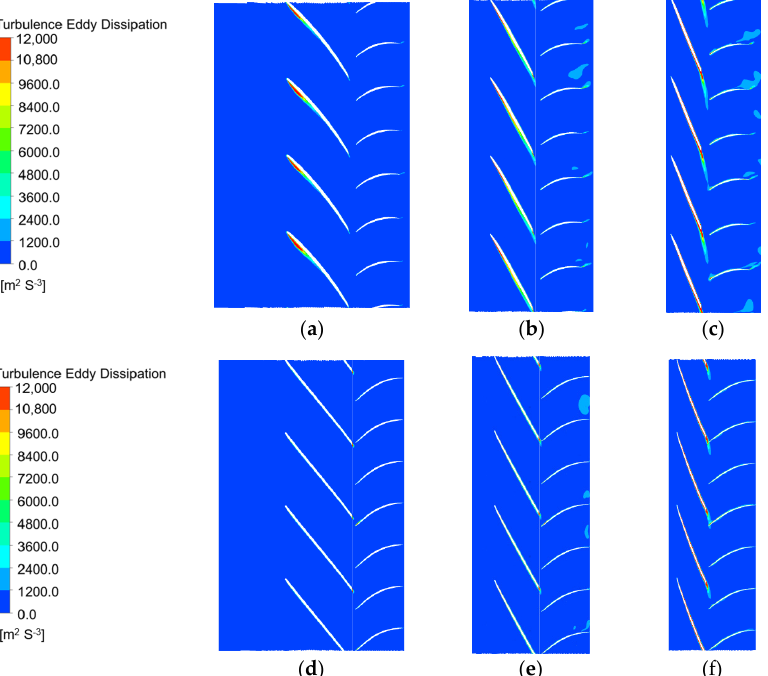
Figure 12. Velocity and streamline distribution in different spanwise. ( a ) Initial scheme at span = 20%. ( b ) Initial scheme at span = 50%. ( c ) Initial scheme at span = 80%. ( d ) Optimized scheme at span = 20%. ( e ) Optimized scheme at span = 50%. ( f ) Optimized scheme at span = 80%.